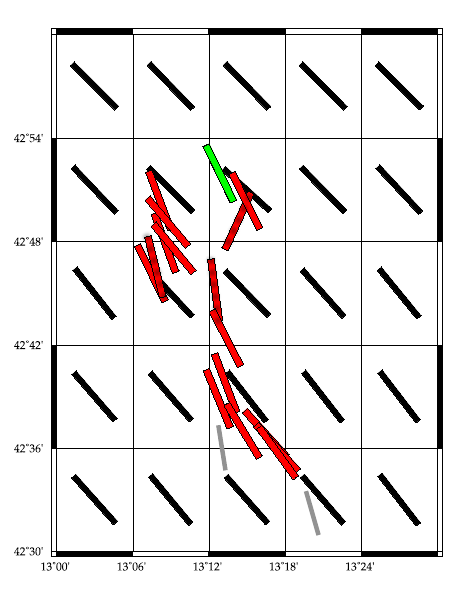
Figure 3 : Location map of the forecast maximum hori- zontal stress (SHmax) orientations (black bars) computed for each cell; the real SHmax orientations extracted by the TDMTs are shown for NF (red and yellow dashed bars; see text for more explanations) and SS (green bar) focal mechanisms. The grey bars show the SHmax trend in- ferred from borehole breakouts.